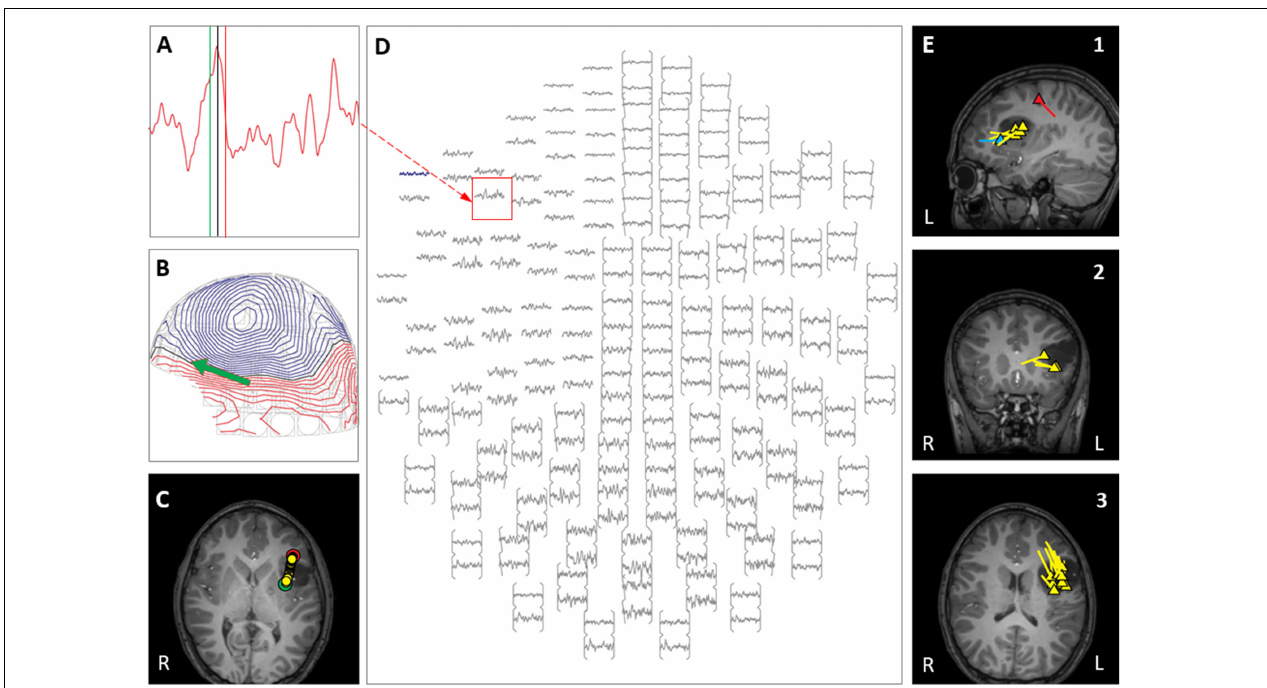
FIGURE 6 | Case 26 (A–E) provide an example of left-sided language activation in the Broca’s area, using a silent verb generation task. (A) Left frontal MEG channel with clear activation pattern between green and red cursor from 425 to 455 ms post stimulus, (B) MEG map at 440 ms post stimulus (black cursor position in A ) with the projected source estimate (green arrow), (C) axial MRI with plotted source origins (round dots) from 425 ms (green) to 455 ms (red), (D) in sensor space with boxed channel (red) as seen in (A) . (E1–E3) The summary pictures demonstrating epileptiform activity (yellow triangles), language activation (blue triangle), and tactile somatosensory activation (red-triangle). Of note, epileptiform discharges appear posterior to the language activation